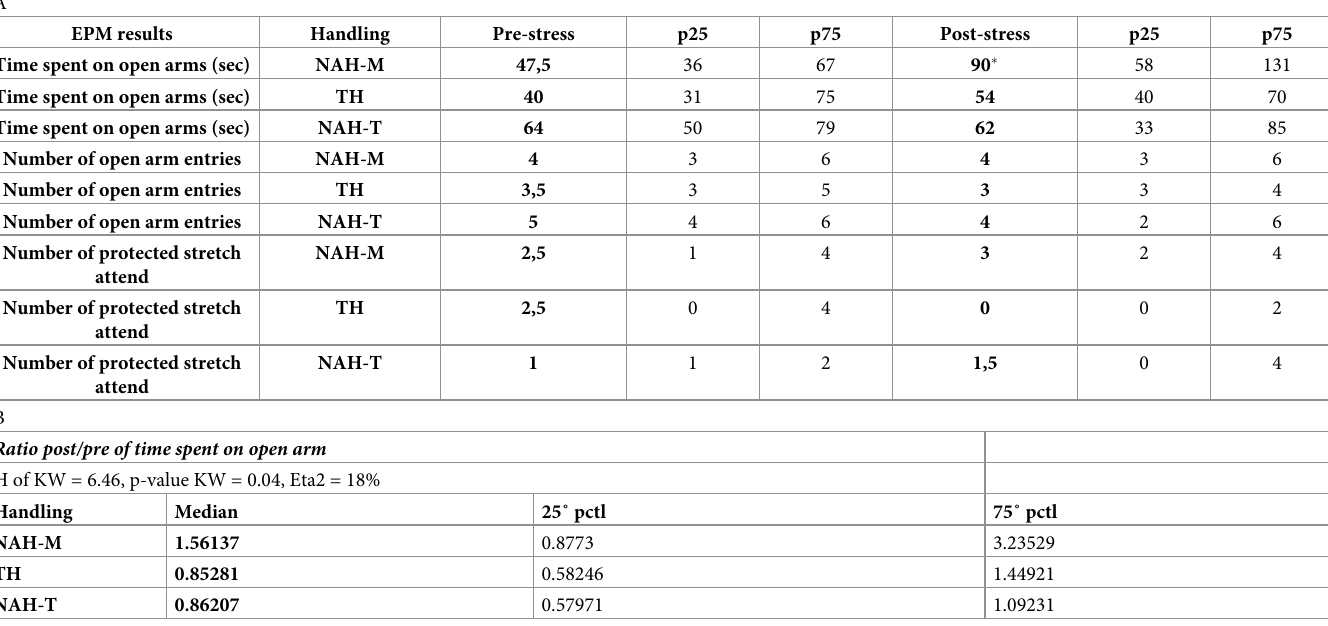
A significant and unexpected finding was that R&L stress caused a significant decrease in BAT temperature in all animals. Several studies have shown that decreased peripheral body temperature (usually caused by adrenergic mediated vasoconstriction) is a fear and stress- related phenomenon, especially in the case of long-lasting inescapable restraint [48–51]. In our Table 3. EPM test: A) time spent on open arm, number of open arm entries and protected stretch attends before and after R&L stress. Median values with interquar- tile ranges (25˚ ptcl-75˚ ptcl.) are reported. Wilcoxon signed rank sum test: � p = 0.025 vs pre-stress value-. B) ratio post/pre increase of time spent on open arm, H value